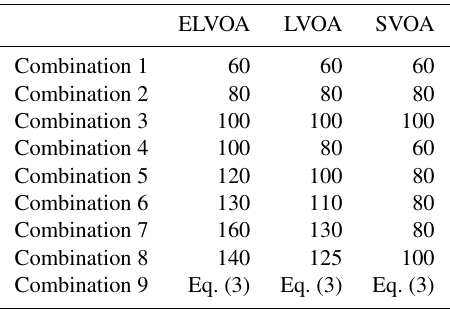
Table 2. The combinations of vaporization enthalpy values used as an input for the evaporation model.